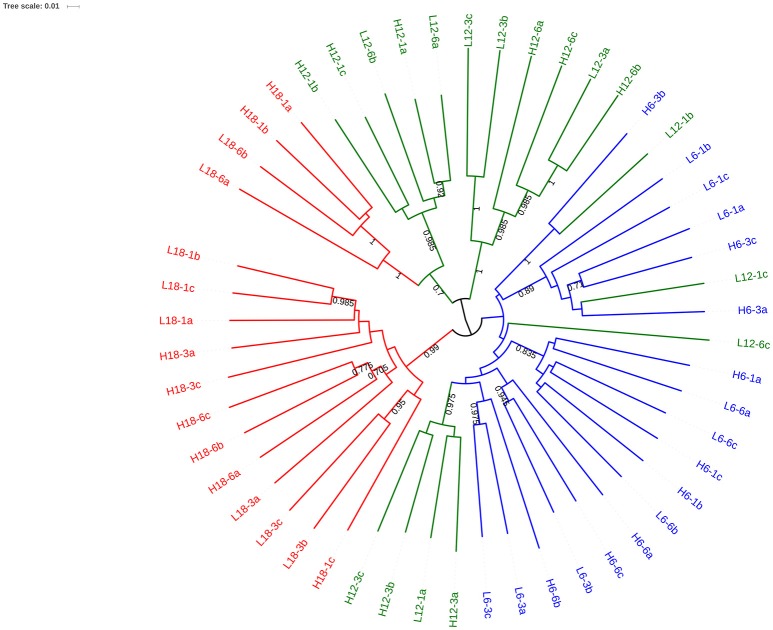
UPGMA tree with Jacknife support using weighted Unifac distance. Nodes with >0.8 Jacknife support are labeled. Branches are color coded to reflect the mean temperature of the experimental regime: 6°C (blue), 12°C (red) and 18°C (green). The labels of each branch correspond to environmental conditions.